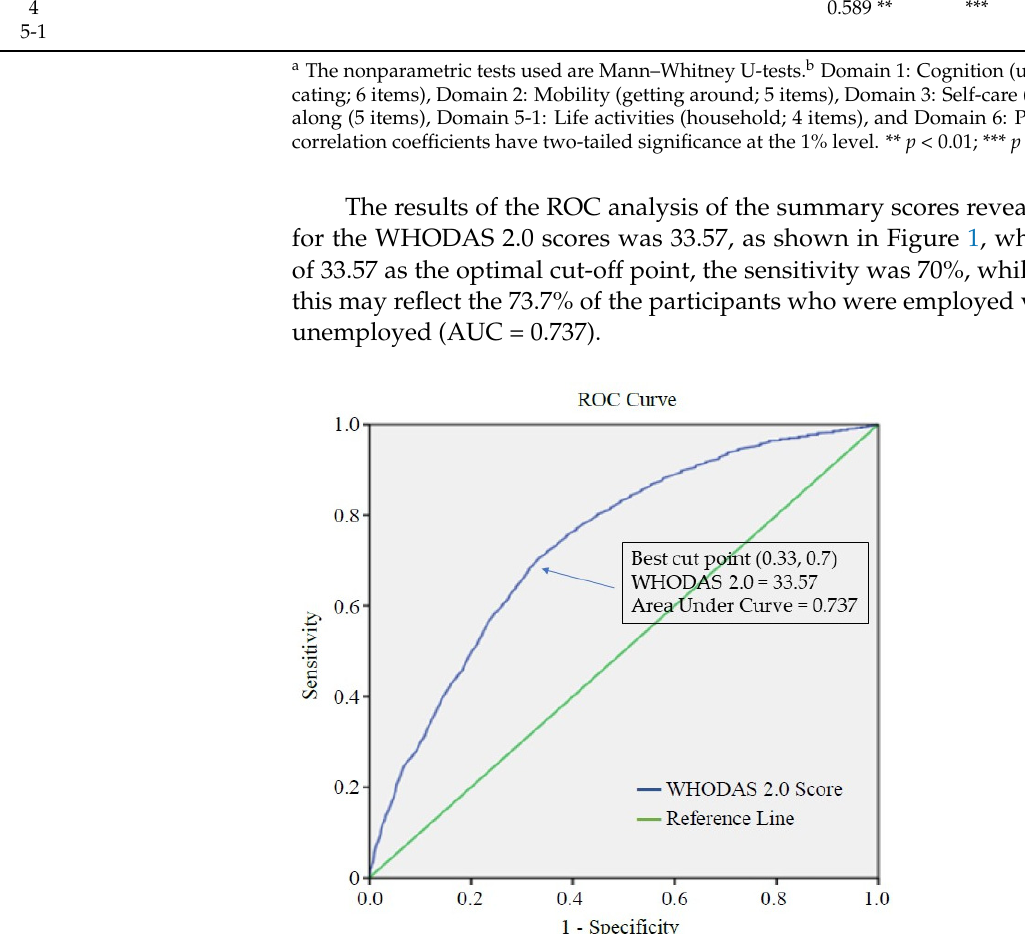
Table 3. Pearson correlation matrix of the WHODAS 2.0 domains ( n = 9886) a .